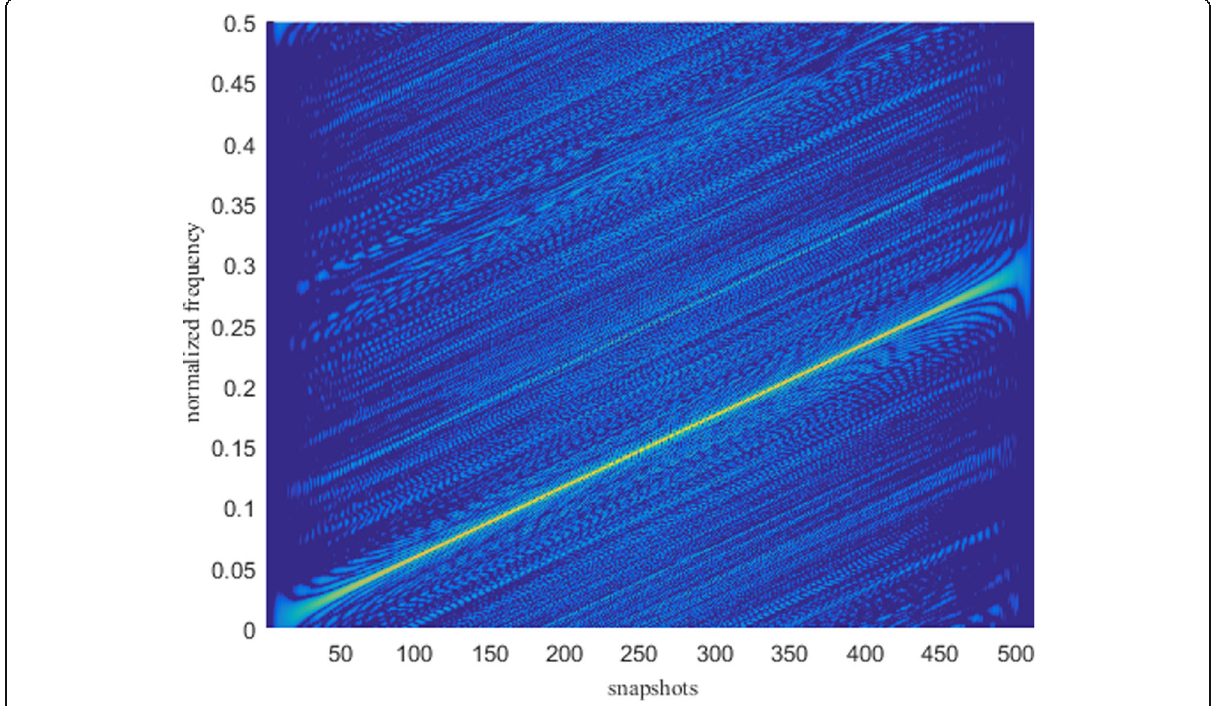
Fig. 4 T-F spectrum of two LFM